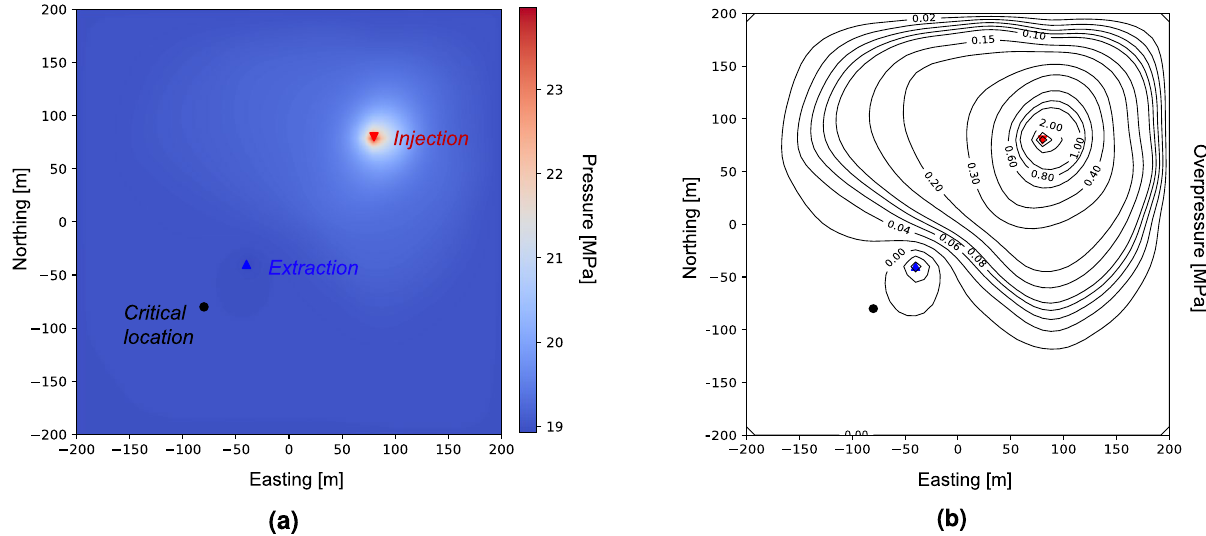
Figure 4. (Color online) ( a ) Resulting pressure distribution within the reservoir. The positions of the injection/ extraction and critical locations are indicated; ( b ) Overpressure values within the prescribed domain extracted from the PIML framework. The blue and red triangles denote respectively the position of the extraction and the injection wells, respectively, while the circle depicts the critical location at which a target pressure is set. These figures were created using Julia Version 1.6.2 73,74 , and the DPFEHM framework 62 1e − 4 . The figure shows the training RMSE error in blue and the testing RMSE in red. We observe a rapid decrease in the RMSE at the beginning of the training. In later epochs (after approximately 4000 epochs), the RMSE starts to decrease much slower, reaching a plateau around 8000 epochs with an overall error reduction of 99%. The minimum RMSE reached using the testing data samples is 0.002786 MPa, which is small in comparison to the overpressure caused by the injection and makes the model sufficiently accurate to be used in practice. That is, other factors beyond errors in the injection rate, such as uncertainty about the heterogeneity, will impact the decision-making process for the extraction rate, and this model could be used to help find an appropriate extraction rate given uncertainty by predicting an ensemble of extraction rates for a variety of permeability fields. After training the PIML frameworks, we can use them to generate extraction rates and overpressures at the critical location given a heterogeneous permeability field. In Fig. 4, we illustrate the resulting pressures and overpressures for a random permeability field within the domain. We used the same permeability field as shown in Fig. 2, and the PIML framework for which we achieved the lowest RMSE ( bsize = 256 and lr = 1e − 4 ). The background pressure of the MPC 26-5 well is 19.0 MPa, which is reflected in the total pressure of the well depicted in Fig. 4a. Fig. 4b shows that the prescribed pressure at the critical location, 0.0 MPa, is obtained by